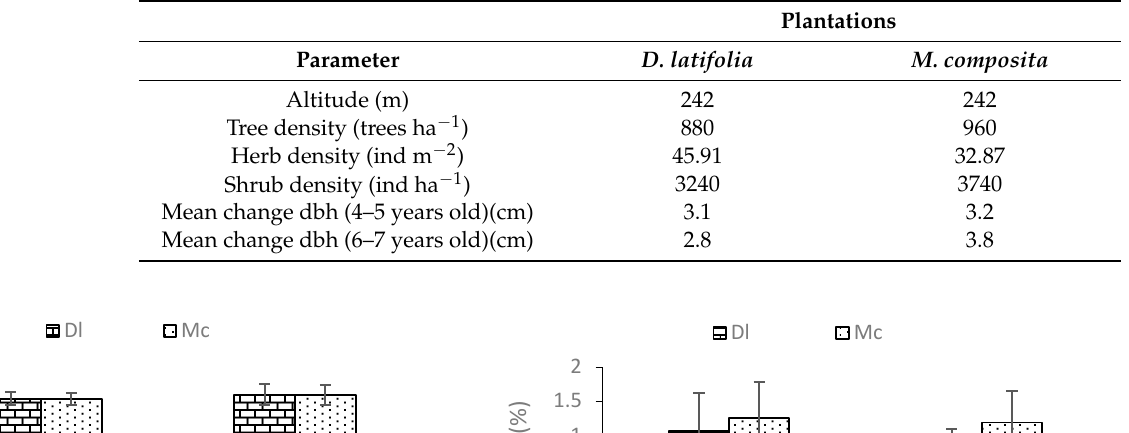
Table 1. Stand structure of D. latifoila and M. composita plantations.